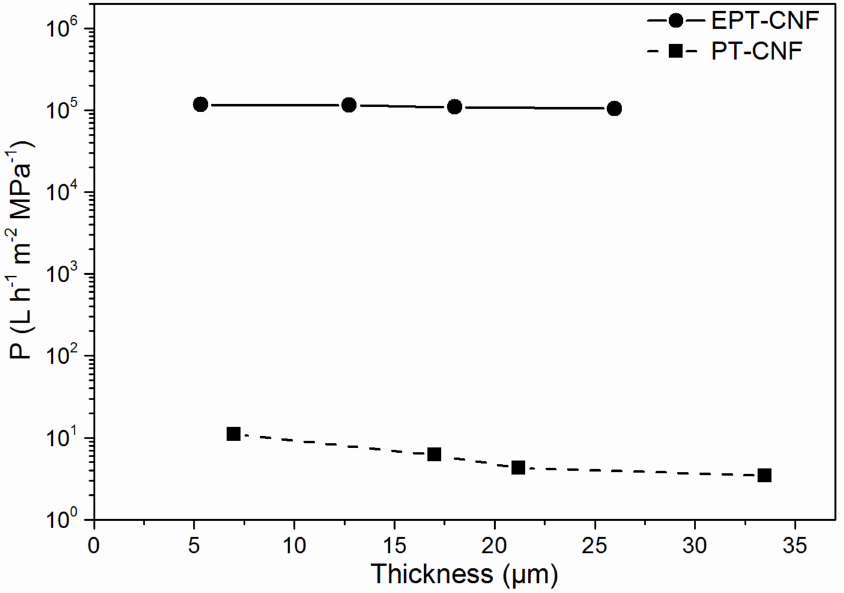
Figure 5. Permeance of (black squares, dashed line) PT-CNF and (black dots, full line) EPT-CNF nanopapers as a function of nanopaper thickness. The error of each data point is <1